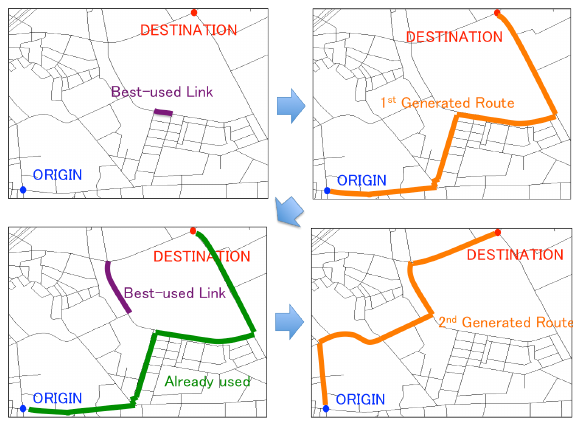
Figure 6. Example of the proposed method